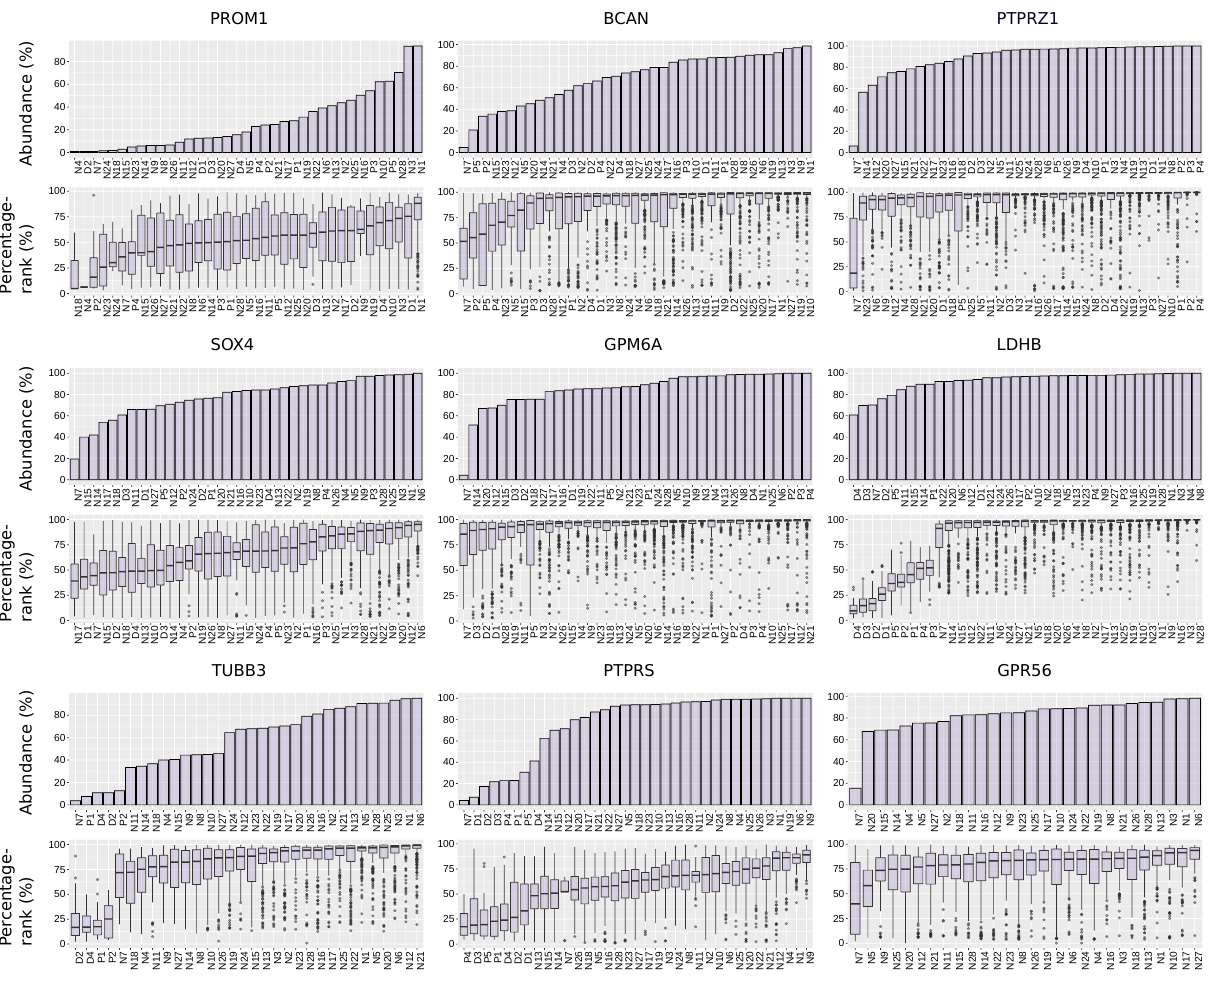
Figure 5. Abundance and percentage-rank of selected markers and PROM1 across samples. The letters “N”, “P” and “D” in the sample ID represent samples from the studies of Neftel et al. [11], Patel et al. [24], and Darmanis et al. [25],